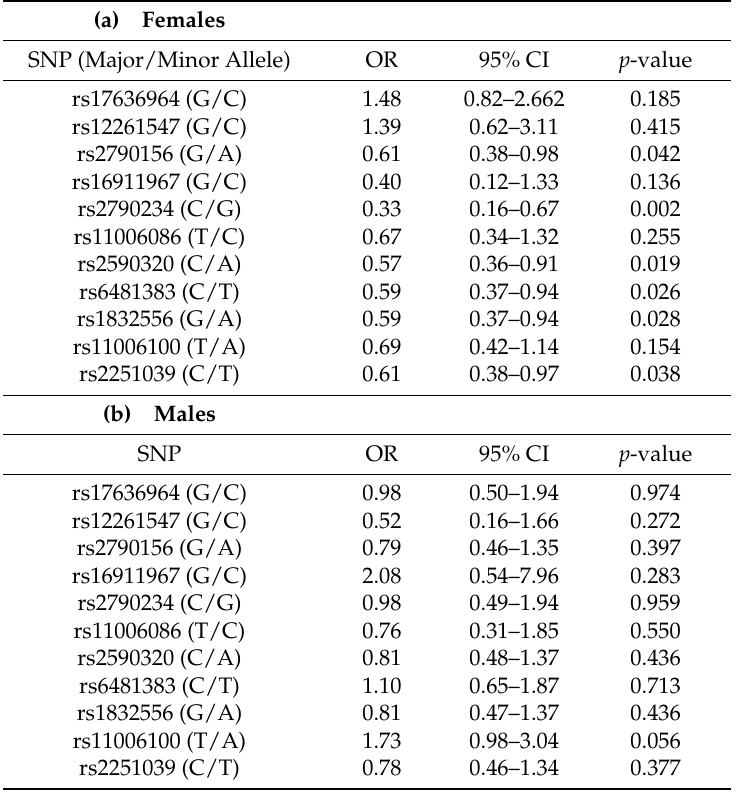
Table 2. Results of the logistic regression models for IPMK SNPs in the sample divided by sex.